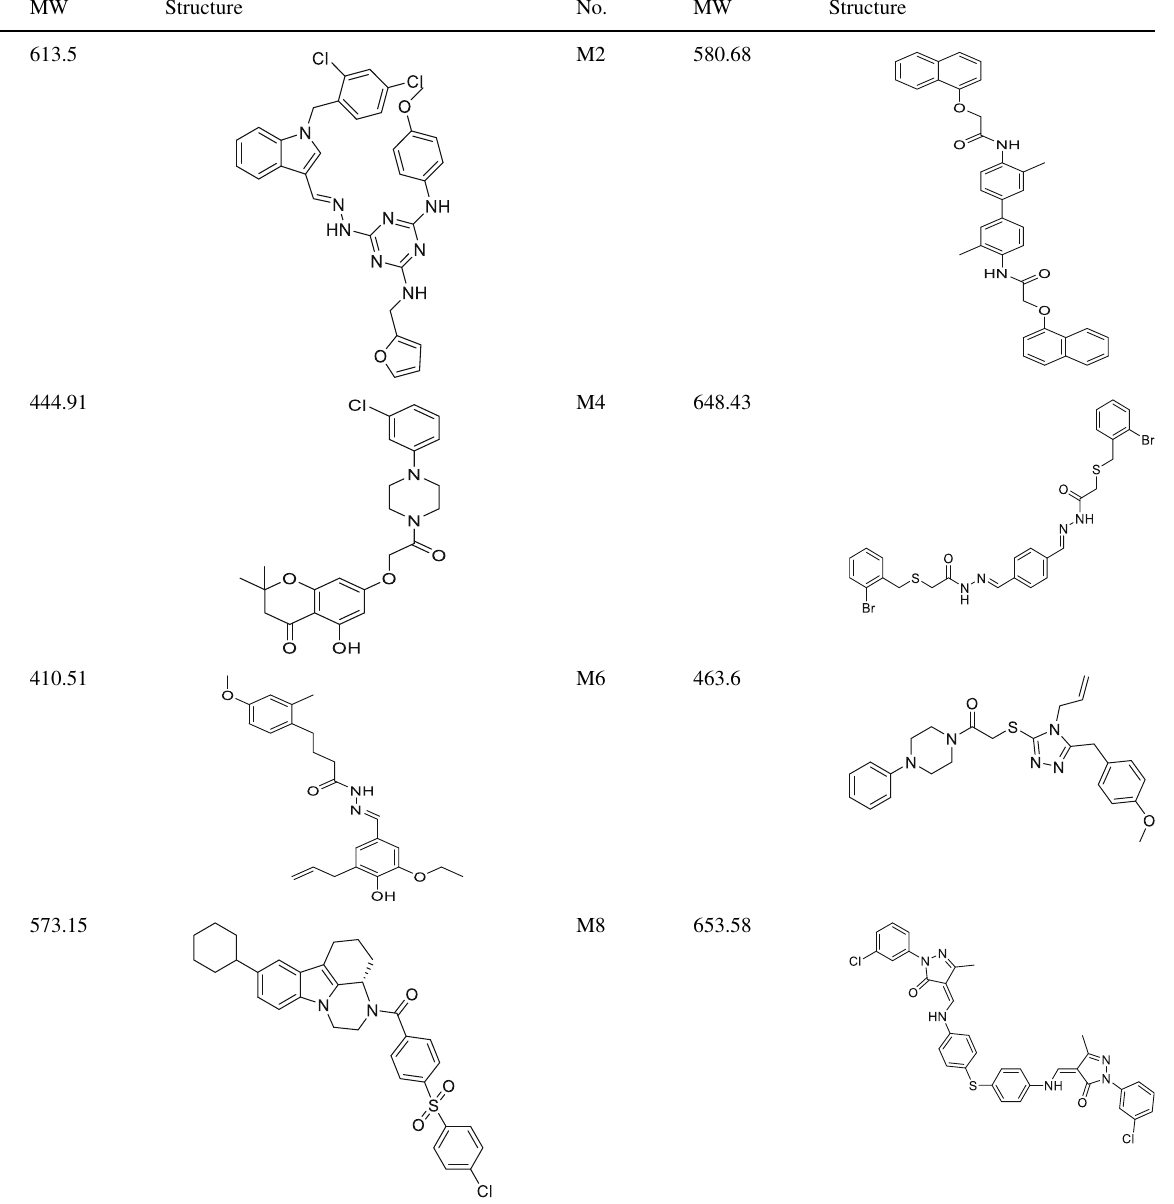
Table 1 Structures of 10 compounds against FXa